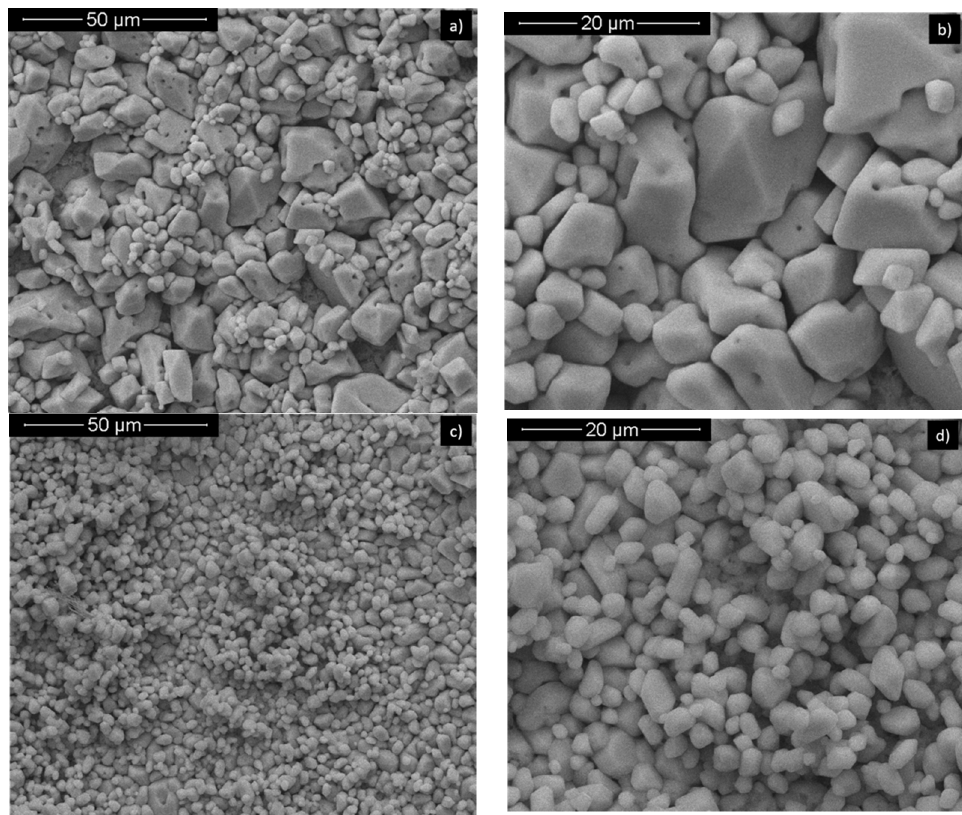
Figure 10. SEM images at different magnifications of Pb and PbO 2 NW electrode after 1000 cycles at 10 C at the end of the 1000th discharge at 40 ± 2 °C: ( a , b ) Pb electrode and ( c , d ) PbO 2 electrode.